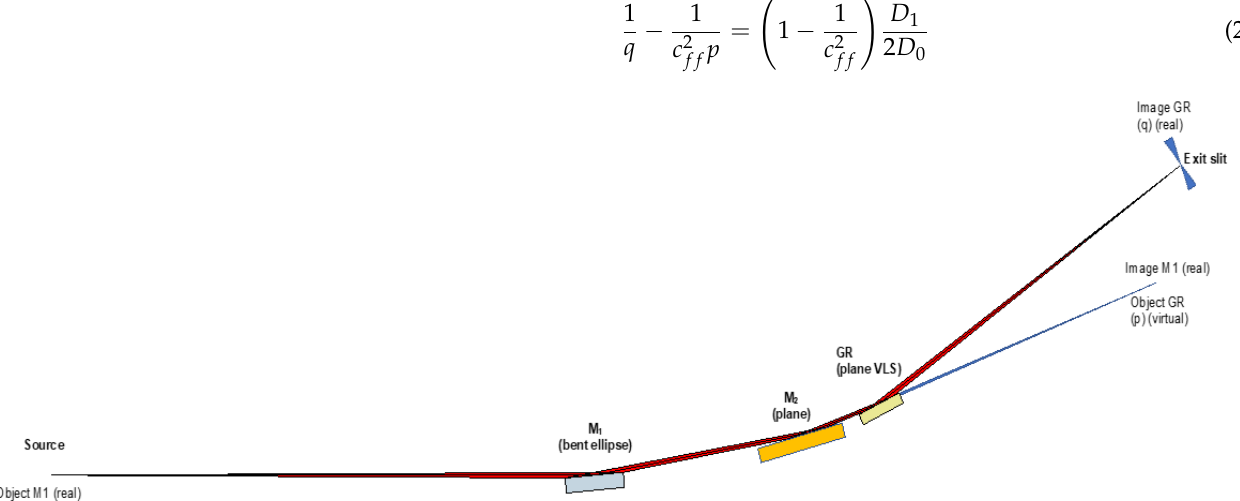
Figure 3. Lateral view and optical scheme of the 2.2 monochromator. M1 is a bendable elliptical mirror, M2 is a variable included angle plane mirror reflecting the beam in the center of the following grating(s) (GR). M1 creates a variable virtual source for the gratings. The beam, after the grating, is focused on the exit slit positioned on the ceiling of the experimental